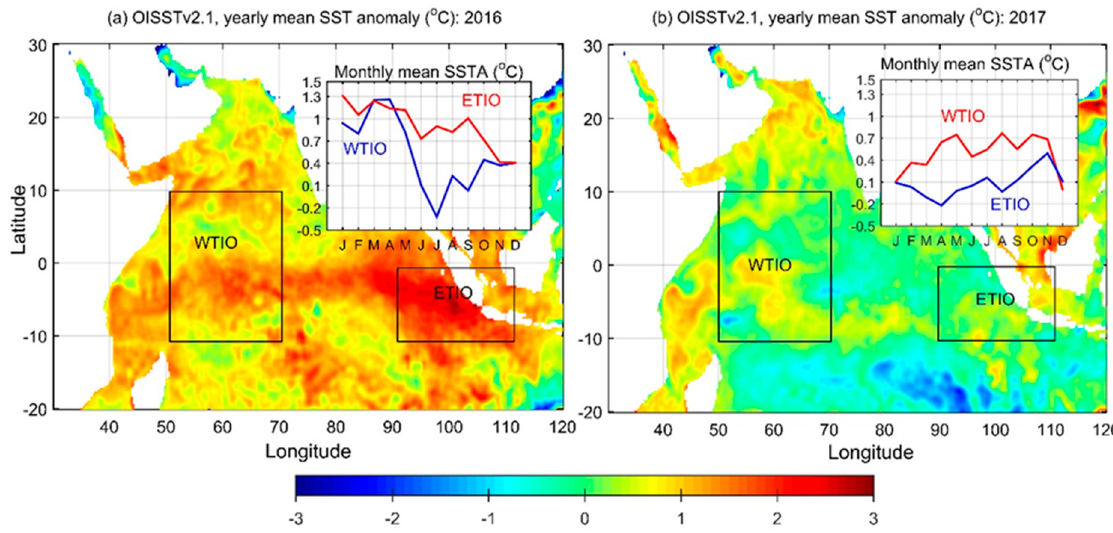
Figure 5. Evolution of SST anomalies (°C) in the TIO in 2016 and 2017 with respect to 1981–2010 reference period, ( a ) yearly mean of SST anomalies in 2016, ( b ) yearly mean of SST anomalies in 2017. The monthly distribution of SST anomalies in 2016 and 2017 is shown within the map. The two boxes represent WTIO (10° S–10° N, 50–70° E) and ETIO (10° S–Eq, 90–110° E). Data obtained from NOAA OISSTv2.1.